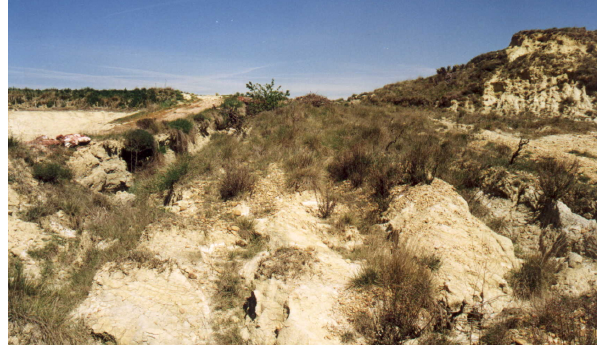
Figure 6. Former vineyard field destroyed by erosion in the low Southern Rhône Valley, with dead vines still visible (Photograph by E.